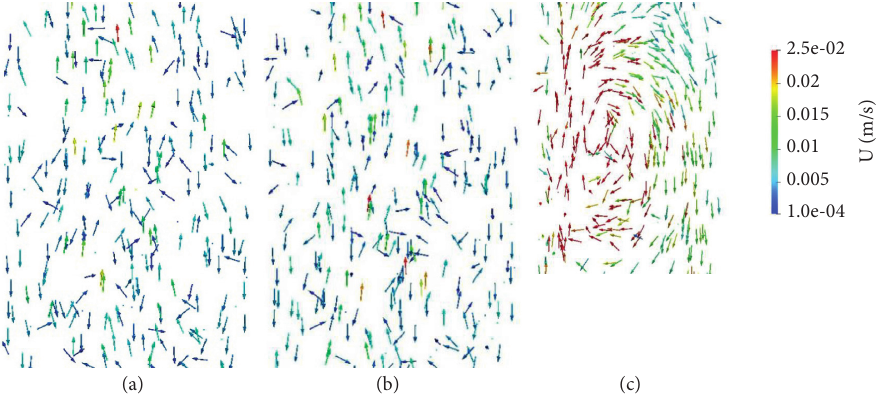
Figure 6: Particle velocity vector diagram of different flow velocity of CSO. (a) 0.001m/s. (b) 0.01m/s. (c) 0.1